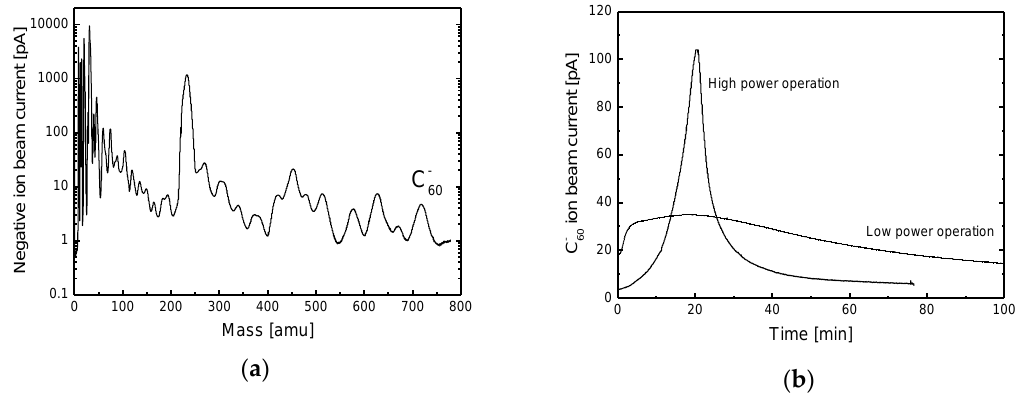
Figure 2. Example results of negative C 60 ion beam production using conventional methods (Cs sputter method): ( a ) mass spectrum of negative ions in a beam extracted from an ion source; ( b ) negative C 60 ion beam currents as a function of time. The two beam currents as a function of time in ( b ) show the results when a different power supplied to the ionizer.